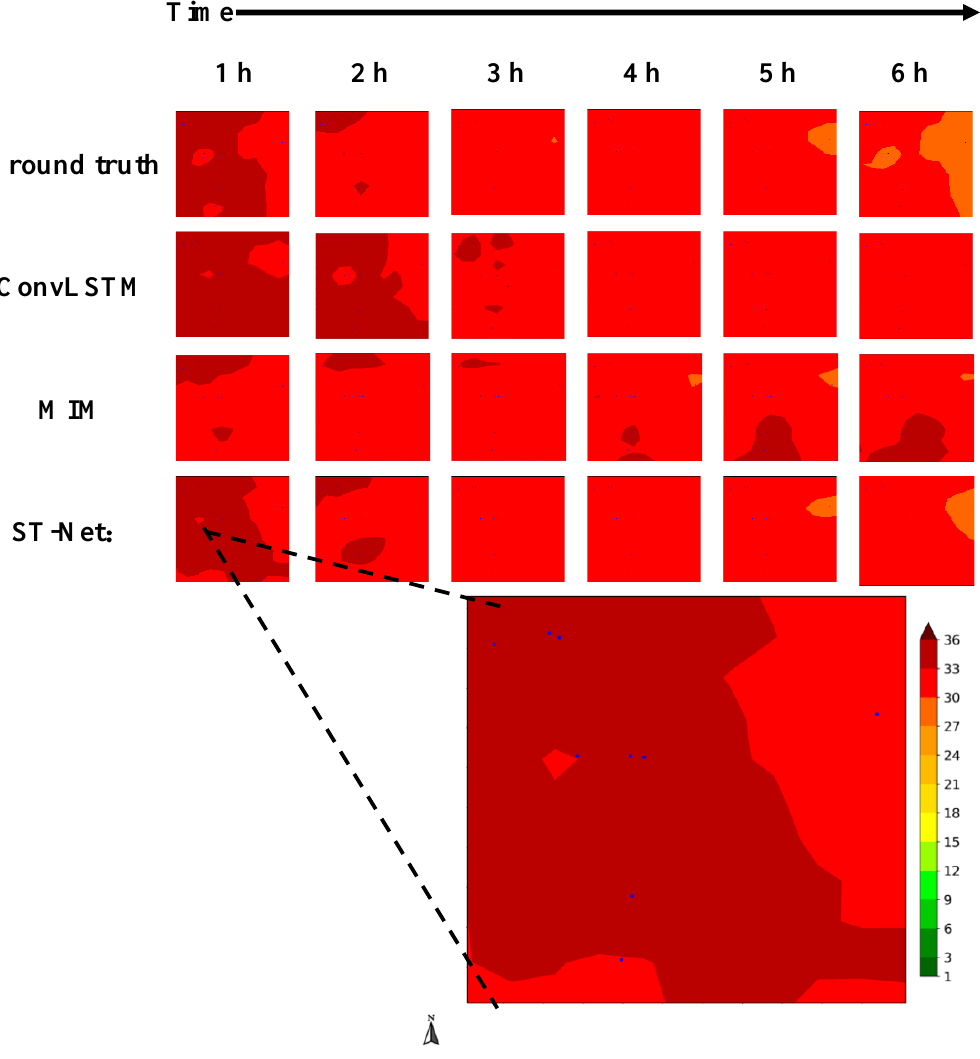
Figure 13. Visualization images of regional air temperature ( ℃ ) forecast results.